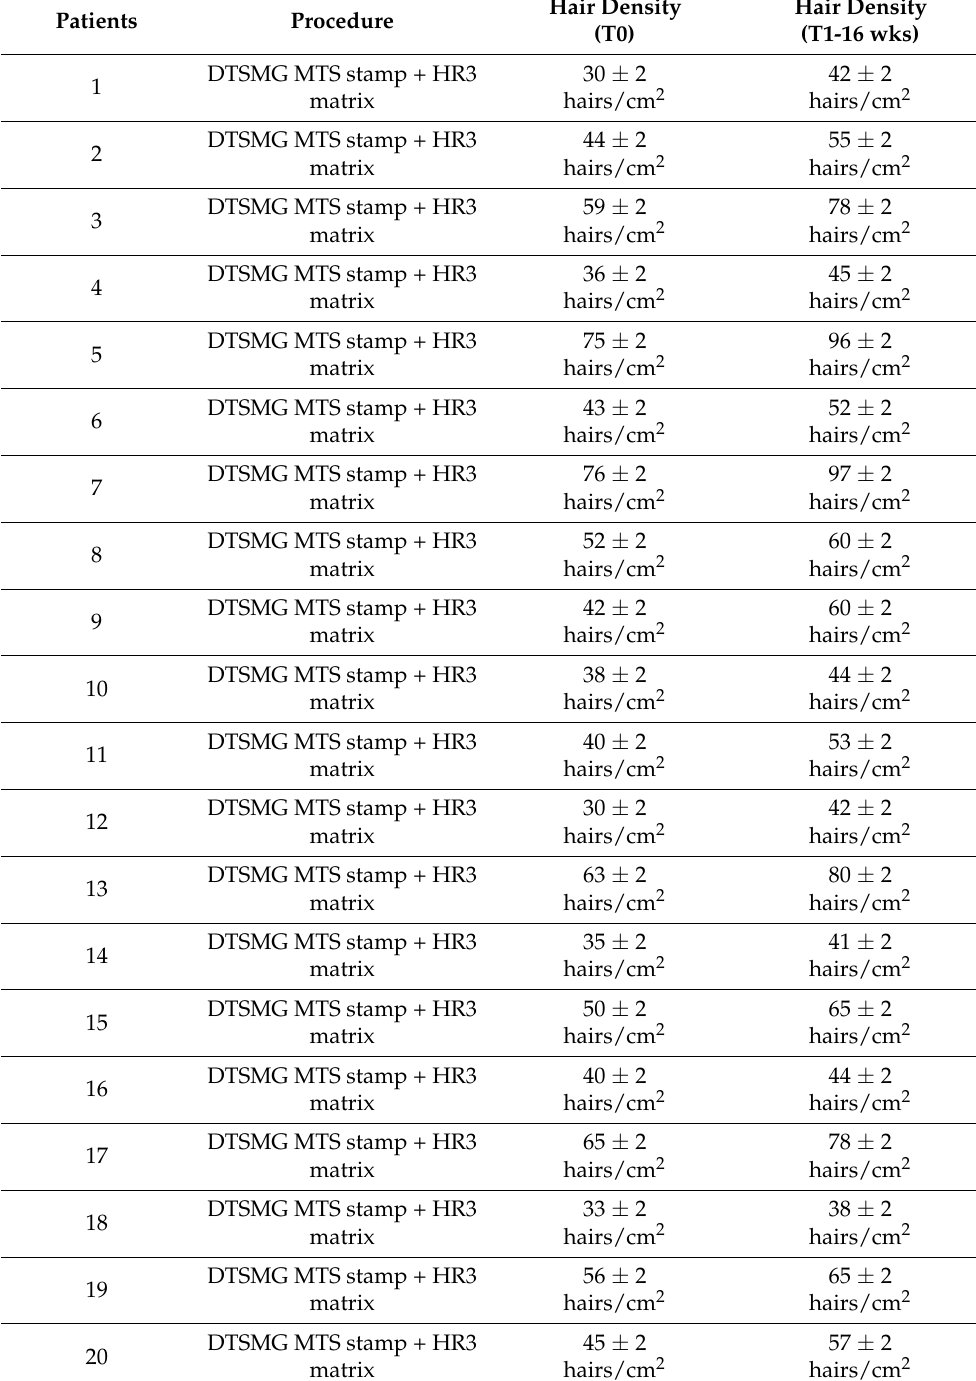
Table 2. In vivo evaluation using trichoscopy analysis in terms of hair density (HD) (hairs/cm 2 )